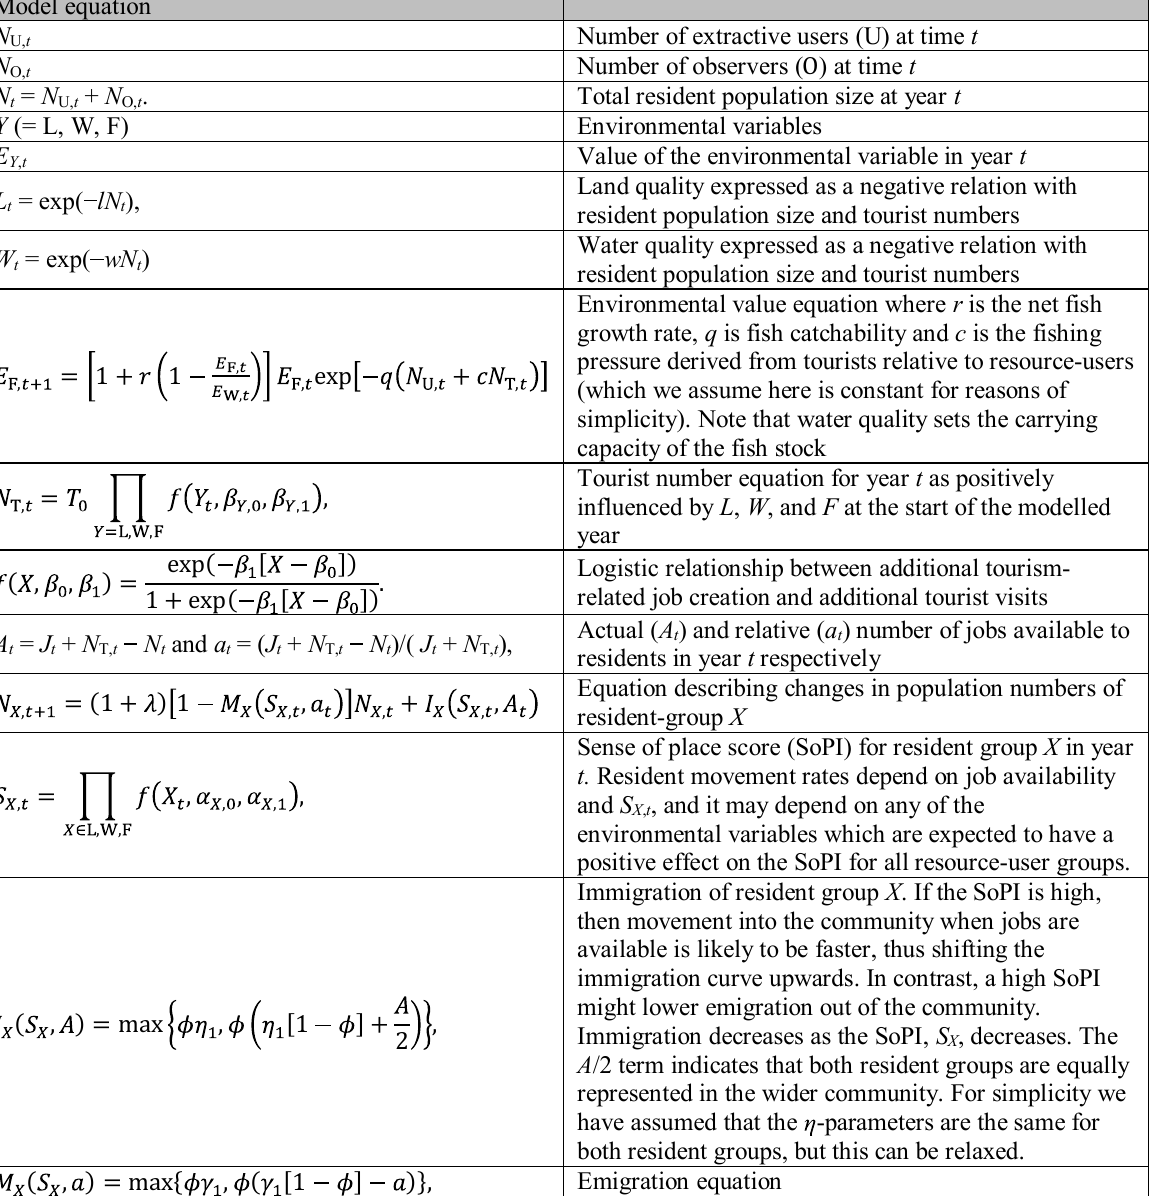
Table A1.2: Model specification for the socio-ecological system of a small coastal community. Model equation